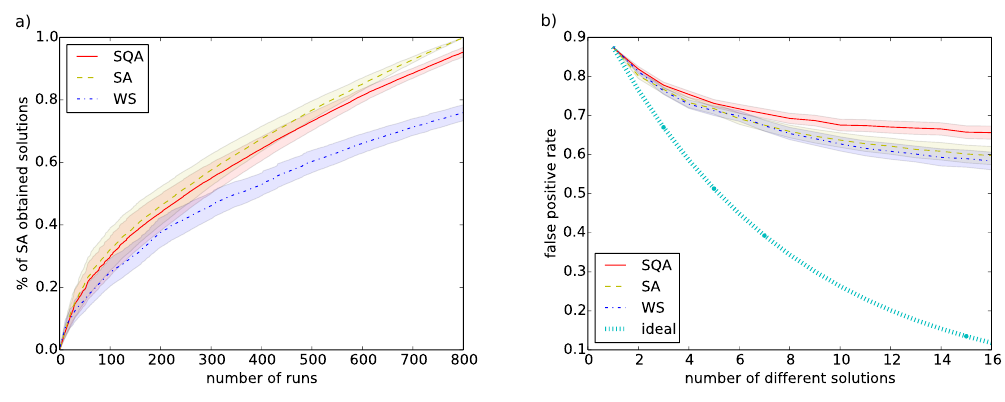
Figure 8: The plots are averaged over 20 randomly generated 3-SAT instances with n = 50 ≈ 3.9. In a) a normalized average of the variables and a clauses-to-variables-ratio of α χ 3 different solutions is shown and in b) the FPR is